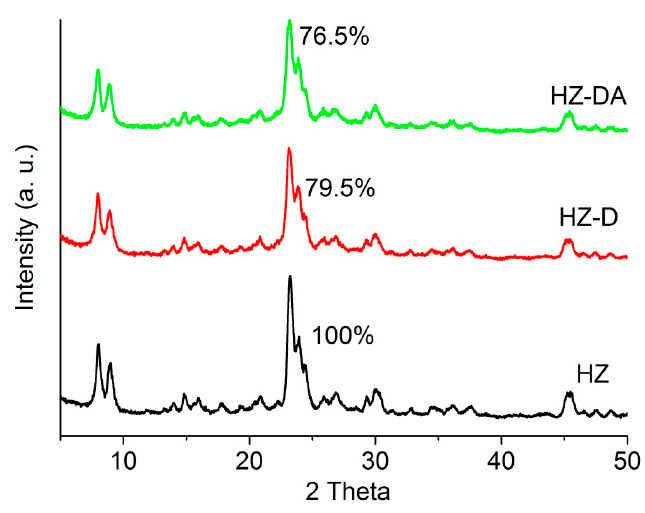
Figure 3. XRD patterns of tested catalysts.